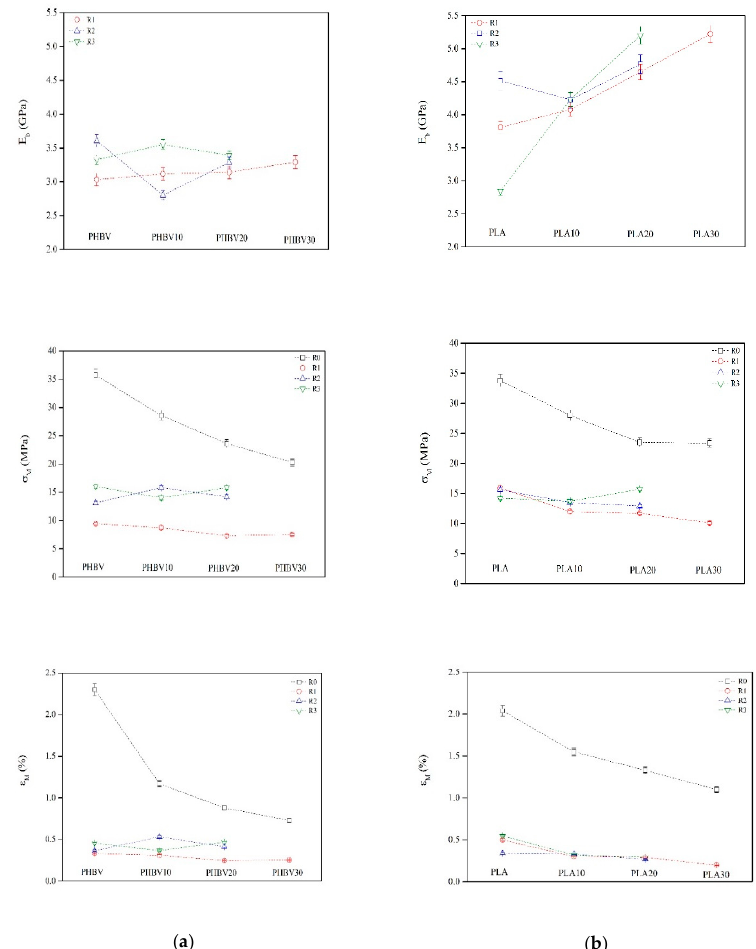
Figure 7. The variation of the elastic flexural modulus ( E b ), the tensile strength ( σ M ) and the elongation at the break ( ε M ) for unrecycled (R0) recycled (R1, R2, R3) PHBV ( a ) and PLA ( b ) biocomposites.